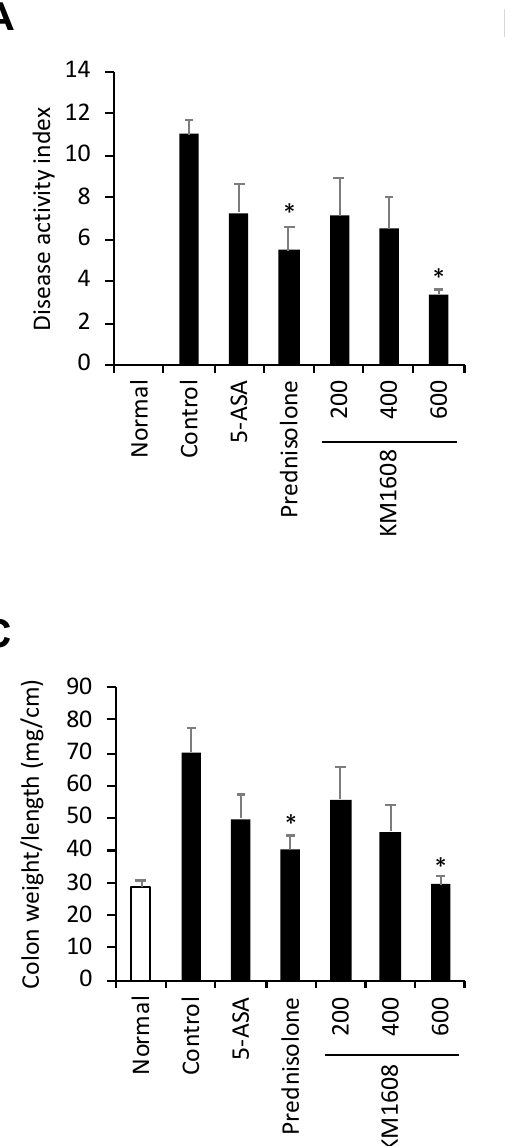
Figure 4. Effect of KM1608 on TNBS-induced colitis in mice. Colitis was induced in ICR mice by the intrarectal injection of TNBS. The animals were treated with KM1608 (200, 400, and 600 mg/kg), 5-ASA (200 mg/kg), and prednisolone (5 mg/kg) orally once per day. 5-ASA and prednisolone were used as the reference drugs. The disease activity index was scored during the experiment ( A ). Colon length and weight were measured at necropsy ( B , C ). The data are presented as the mean ± SEM. n = 6–8, * p < 0.05 vs. control.